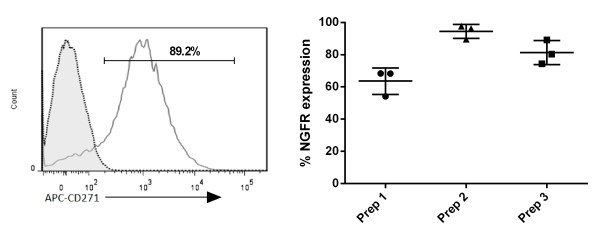
High transduction of lentivirus in primary human T cells. Primary CD45RA+ T cells were transduced using the ‘final’ simplified lentivirus generation and concentration protocol in combination with modifications made to the culturing conditions. Left panel shows representative histogram from one donor of NGFR expression following transduction with lentivirus. Right panel shows the percentage NGFR expression from three lentivirus preparations in nine independent experiments. Transduction efficiency was determined 24 hrs post-transduction using flow cytometry to determine the percentage of NGFR expression.